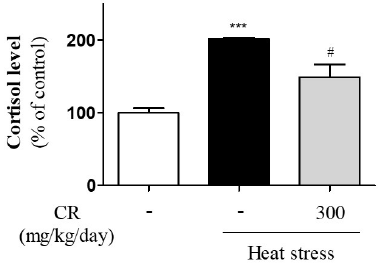
Figure 2. Repressive effect of CR on heat exposure ‐ induced enhancement of cortisol secretion. The white, black and gray bars indicate the control group, the heat ‐ stressed vehicle ‐ treated group and heat ‐ stressed CR ‐ treated groups, respectively. Values are expressed as means ± SEM. *** p < 0.001 as compared with the control group. # p < 0.05 as compared with the heat ‐ stressed vehicle ‐ treated group.